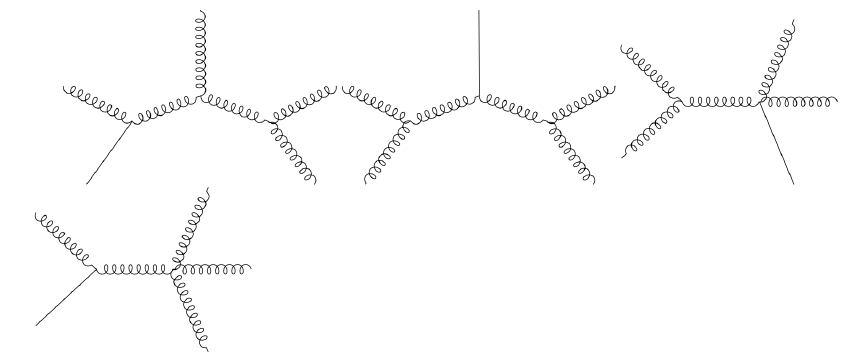
Figure 10 . The four types of diagrams for φAAAA process.The straight line is a scalar field.